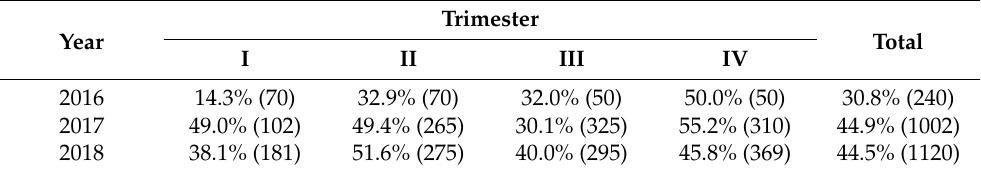
Table 1. Percentage of schools with Aedes spp. mosquitoes observed between 2016 and 2018. The total amount of inspected institutions is included in parentheses.